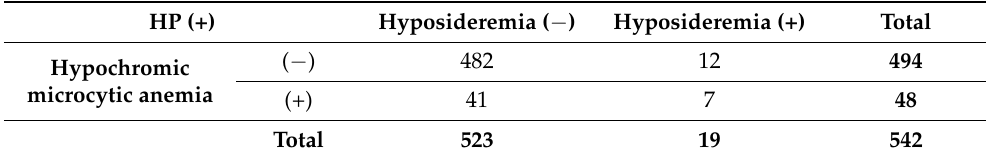
Table 1. Structure of the group of children with H. pylori infection and iron-deficiency anemia. HP (+) Hyposideremia ( − ) Hyposideremia (+) Total ( − ) 482 Hypochromic microcytic anemia (+) Total 523